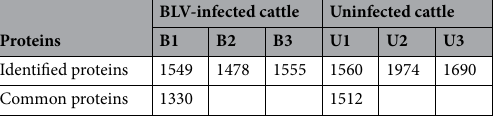
Table 2. Number of proteins identified in milk sEV from three BLV-infected and three uninfected cattle.